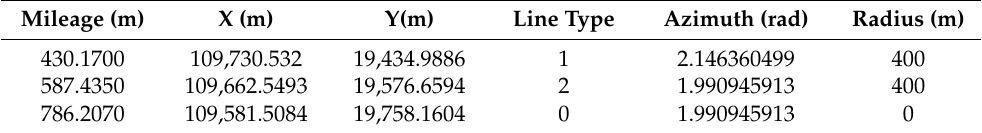
Table 1. Example of horizontal curve design.